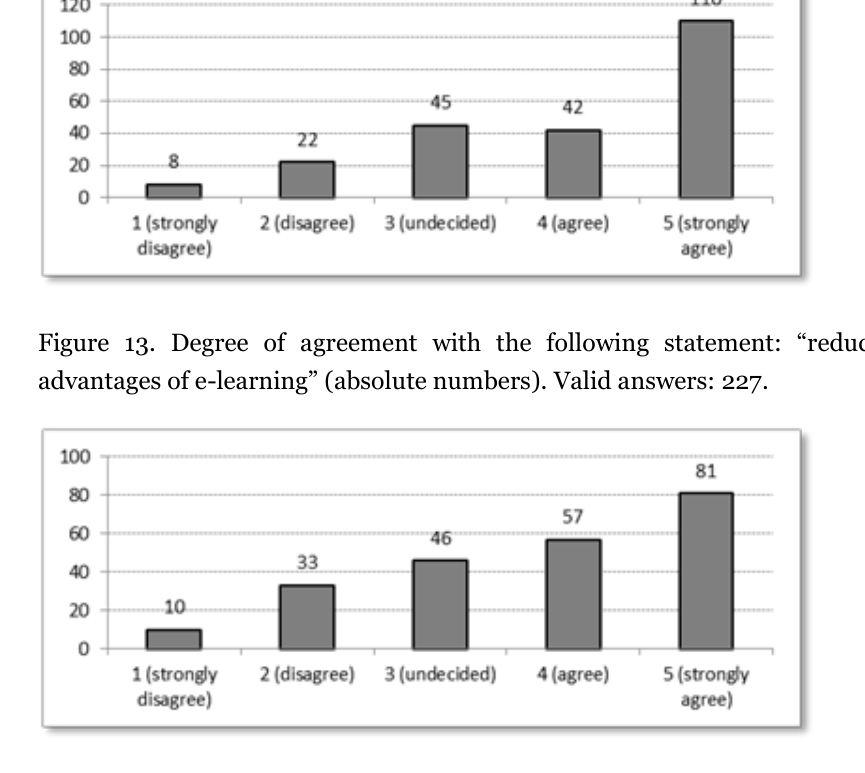
Figure 14. Degree of agreement with the following statement: “the possibility of accessing courses without barriers is an advantage of e-learning not found in face-to-face tuition” (absolute numbers). Valid answers: 227.